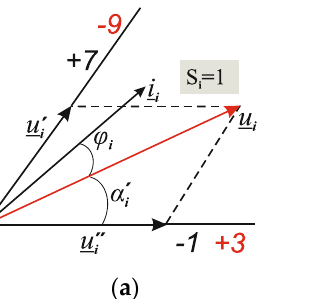
Figure 5. Geometric interpretation of an example vector modulation: ( a ) of input voltage vector, ( b ) output current vector.